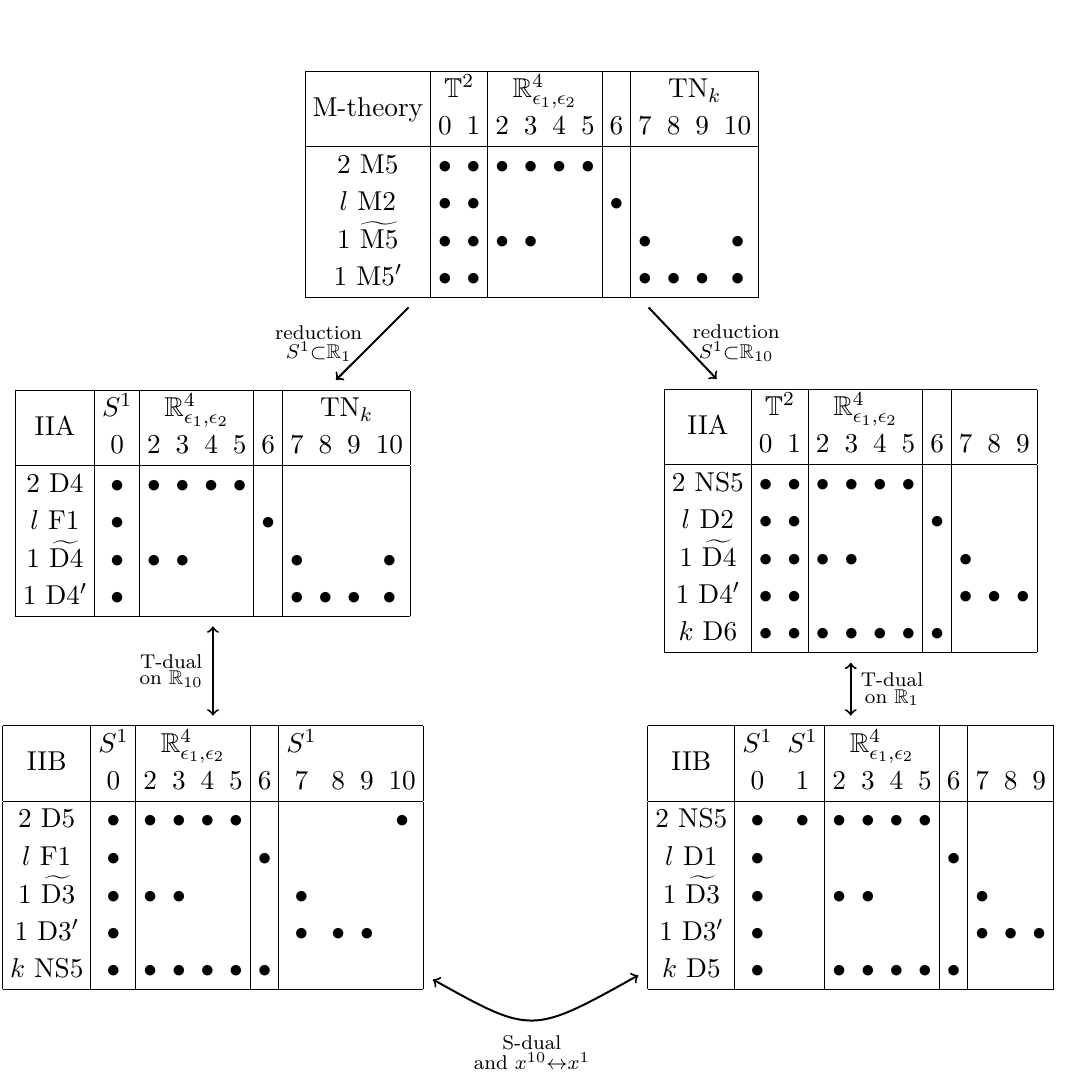
Table 1 . Brane set-up for codimension 2 and codimension 4 defect. The theory without defect is realised via 2 M5 branes transverse to a Taub-NUT space TN k , which is a resolution of the C 2 / Z k singularity. The isometries of TN k can be identified with the admissible (cid:15) 1 , 2 twists defining